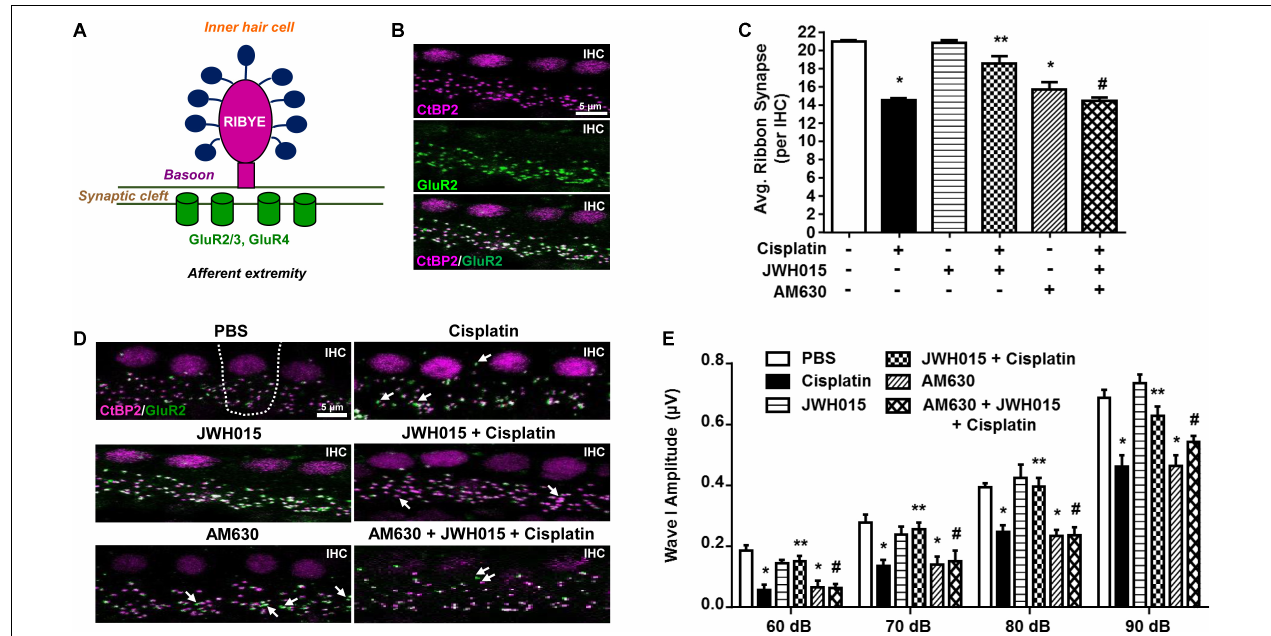
FIGURE 4 | Activation of CB2R protects against cisplatin induced loss of ribbon synapse. (A) The cartoon represents a typical ribbon synapse at the inner hair cell (IHC). It is primarily composed of two major components: presynaptic RIBEYE and glutamate receptors (GluR) at the post-synapse. (B) Representative images shows whole mount preparations co-stained with presynaptic CtBP2 (for RIBEYE, magenta) and postsynaptic GluR2 (green). Functional ribbon synapses are complexes showing both CtBP2 and GluR2 immunolabeling (white) apposing each IHC. (D) The whole mount preparation form the basal region of cochleae from treated animals were dissected and stained for CtBP2 and GluR2. Representative images are shown. White arrows indicate single staining of either CtBP2 or GluR2. Functional synapse complexes (CtBP2 + GluR2) were quantified by averaging the numbers from 30 IHCs per samples. The bar graph (C) represents the average number of synaptic complexes (mean ± SEM) per IHC ( n ≥ 4). Pre-treatment with JWH015 protected against cisplatin-induced loss of functional synapse. CB2R antagonist, AM630, administered alone or in combination with JWH015 + cisplatin produced significant reductions in functional ribbon synapses. (E) ABR wave I amplitude of different treatment groups at 60, 70, 80, and 90 dB SPL (32 kHz) was computed from sorted ABR wave forms. The bar graph represents mean wave I amplitude ± SEM ( n = 12). Cisplatin decreases wave I amplitude indicating synaptopathy which was completely reversed by pre-treatment with JWH015. Blockade of CB2R activation by AM630 resulted in decrease in wave I amplitude. ∗ p < 0.05 vs. vehicle; ∗∗ p < 0.05 vs. cisplatin; and # p < 0.05 vs. JWH015 + cisplatin (one-way